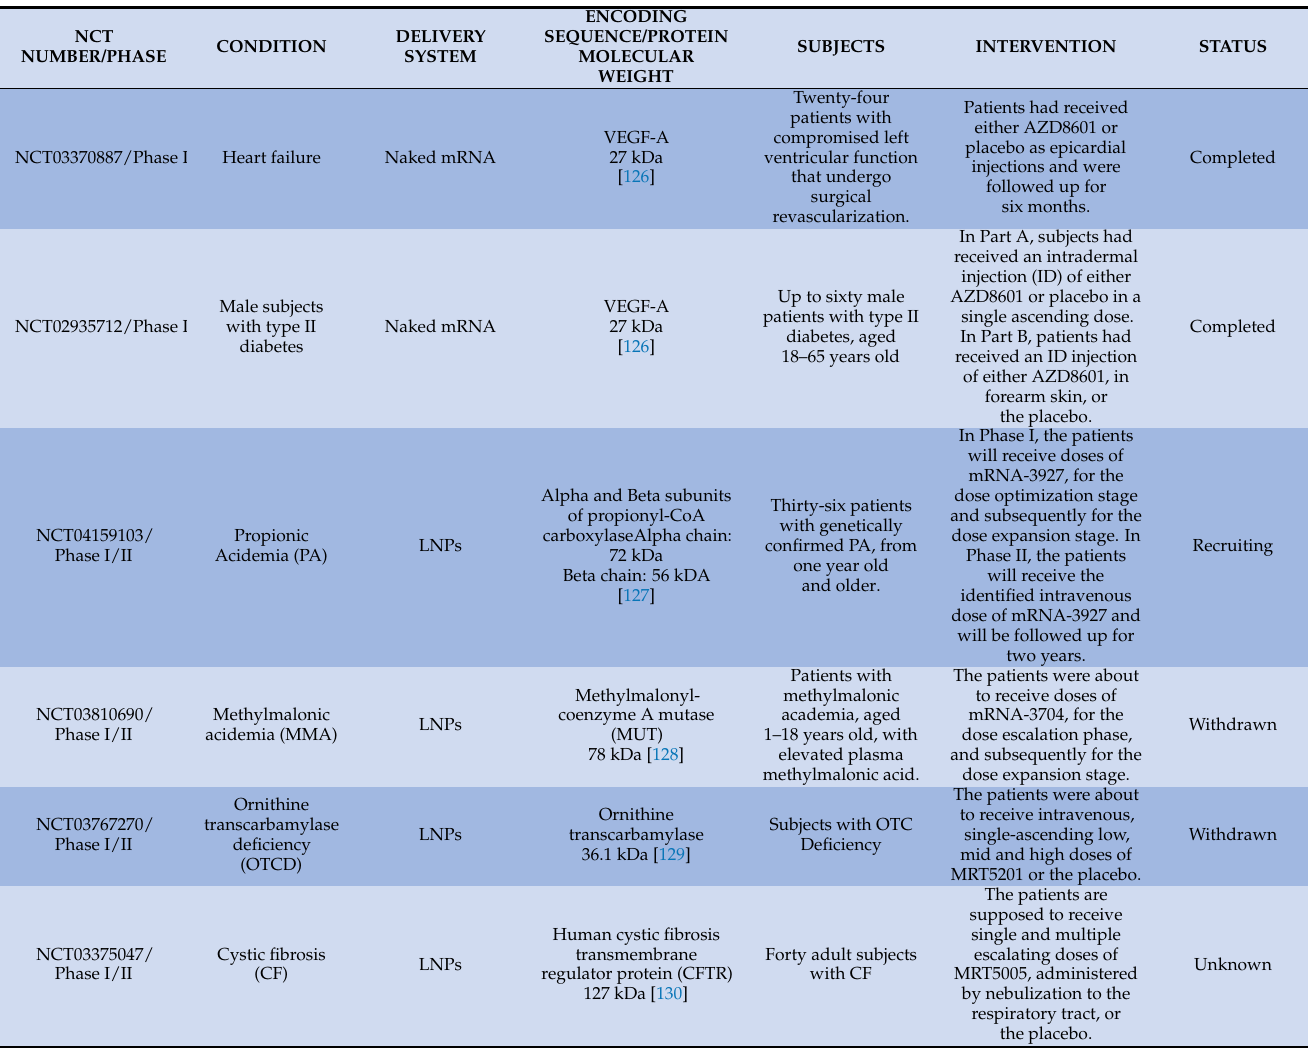
Table 1. Clinical trials that utilize mRNA for protein replacement